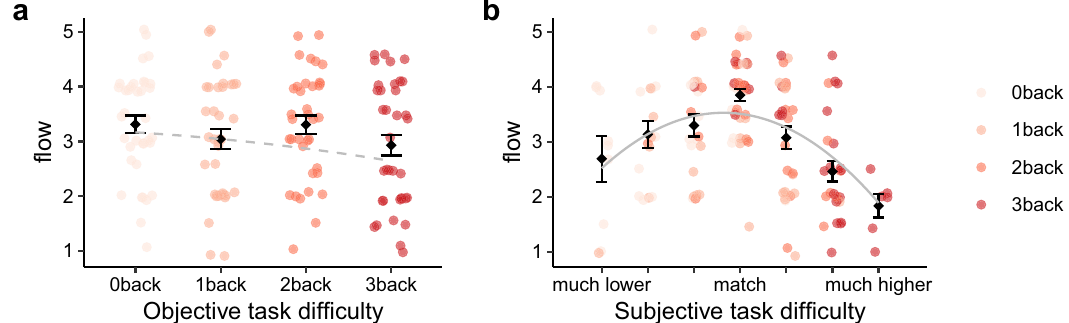
Figure 1. Psychological flow changes as a function of task difficulty. ( a ) Psychological flow failed to fit an inverted U-shape pattern with increasing objective task difficulty. ( b ) Psychological flow fit an inverted U-shape pattern with increasing subjective task difficulty. The means ± standard errors are shown.